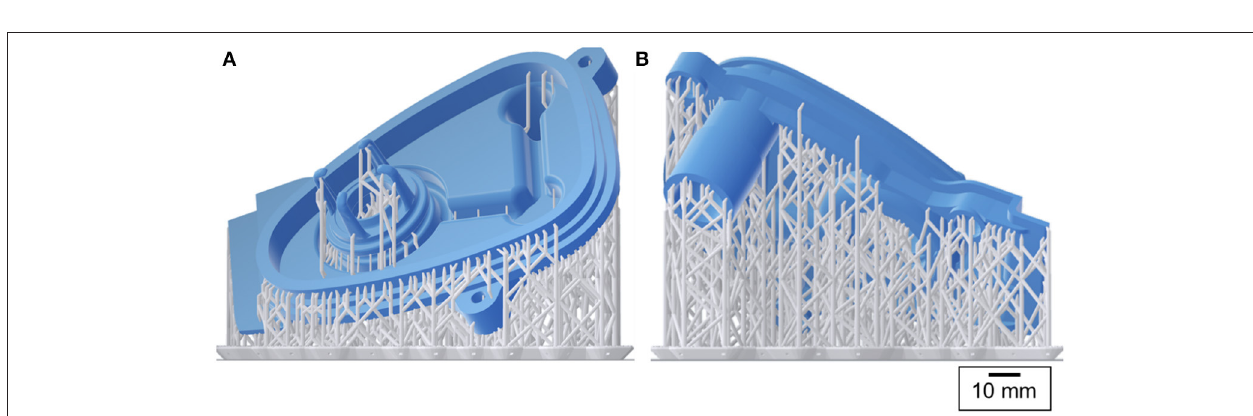
FIGURE 3 | Key functional design features of the manifold cover marked in red [ (A) top and (B) bottom views].